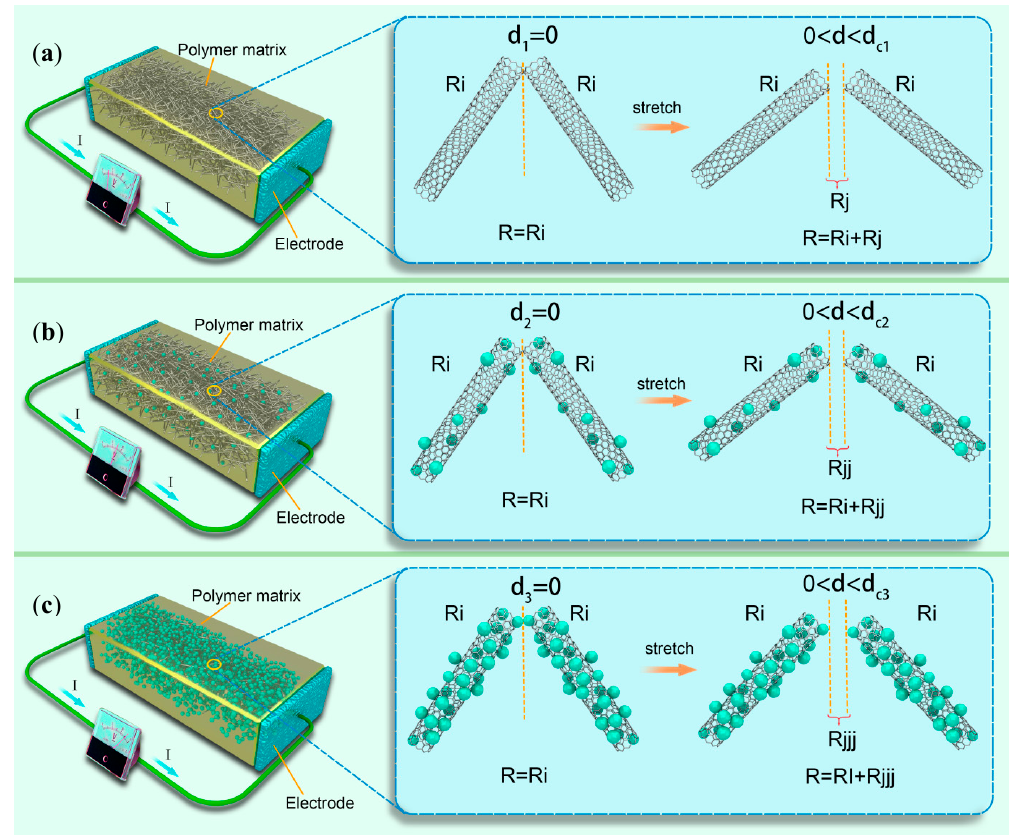
Figure 7. Schematic sensing models of sensors: ( a ) CNTs, ( b ) Ag@CNTs1, and ( c ) Ag@CNTs2.